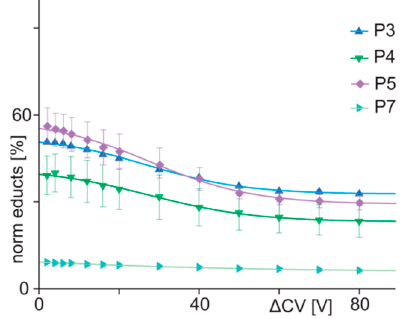
Figure 4. Courses of normalized educt ion intensities of immune complexes of anti-hcTn I antibody and peptides 3 (blue triangles), 4 (green triangles), 5 (purple squares), and 7 (light blue triangles) are shown as functions of collision cell voltage differences ( ∆ CV). Each data point is the mean of at least two independent measurements (see Table S1). Vertical bars indicate standard deviations. The sigmoidal-shaped curves were fitted using a Boltzmann function. The curve parameters are given in Table 2.